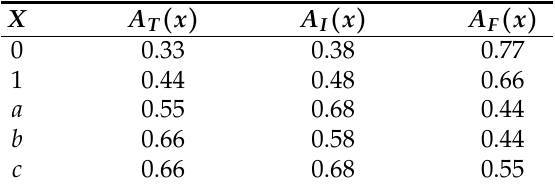
Table 8. Tabulation representation of A = ( A T , A I , A F )